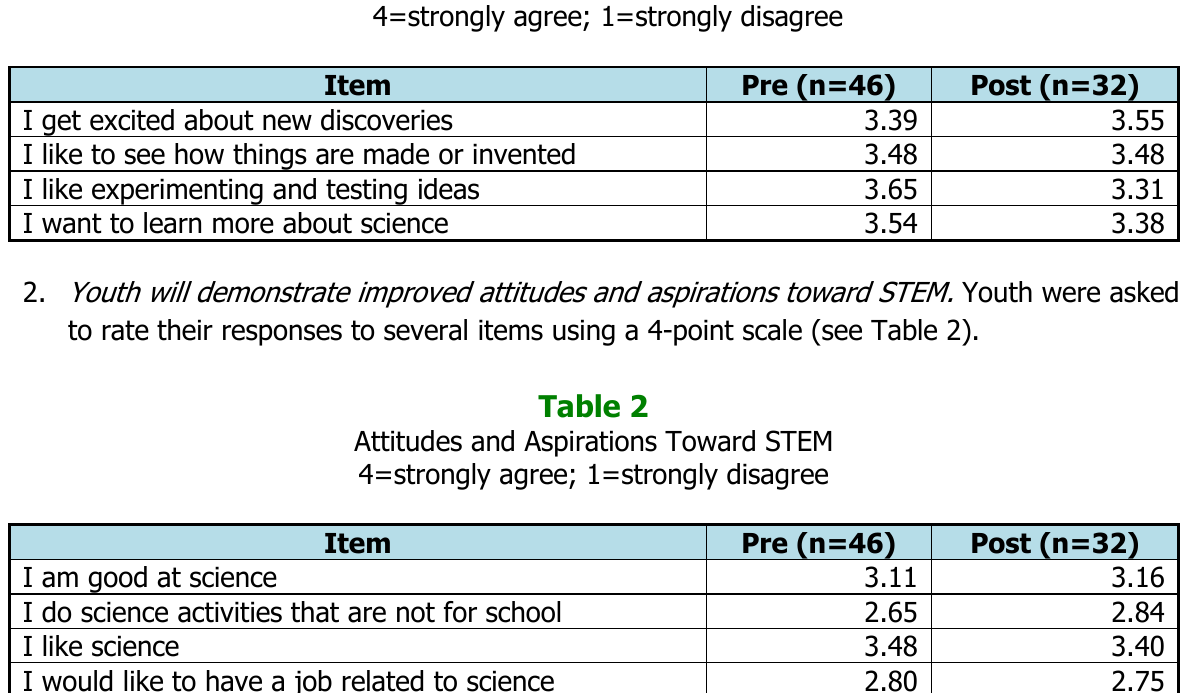
Interest and Engagement in STEM